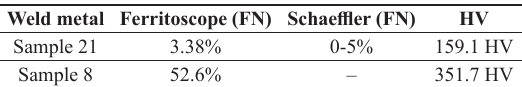
Table 5. Results of microhardness (HV) and ferrite number (FN) in the weld metal. Weld metal Ferritoscope (FN) Schaeffler (FN)